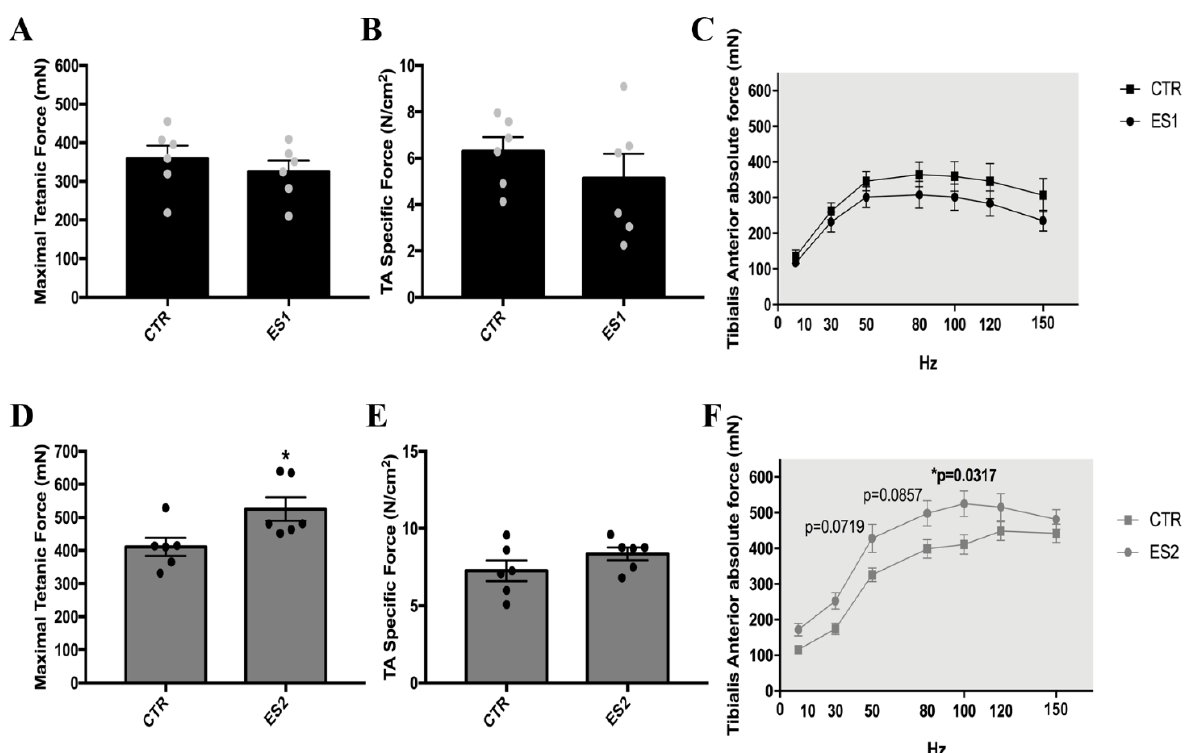
Figure 3. Analysis of muscle function in vivo following one and two weeks of electrical stimulation. ( A – C ) After one week of electrical stimulation, the maximal tetanic force, specific force, and absolute force were analyzed, respectively. ( D – F ) After two weeks of electrical stimulation, the maximal tetanic force (100 Hz), specific force, and absolute force were measured, respectively. The data were presented as mean ± SEM. In the statistical analysis, an unpaired t -test and a Mann-Whitney test were employed (n = 6). * p < 0.05 vs. respective control.